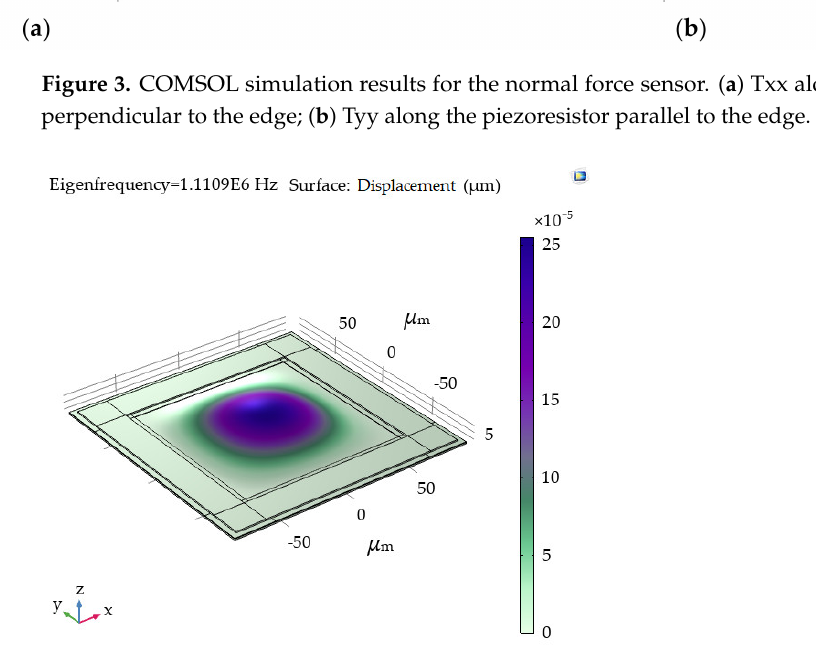
Figure 4. Resonant frequency simulated to be 1.11 MHz by COMSOL.